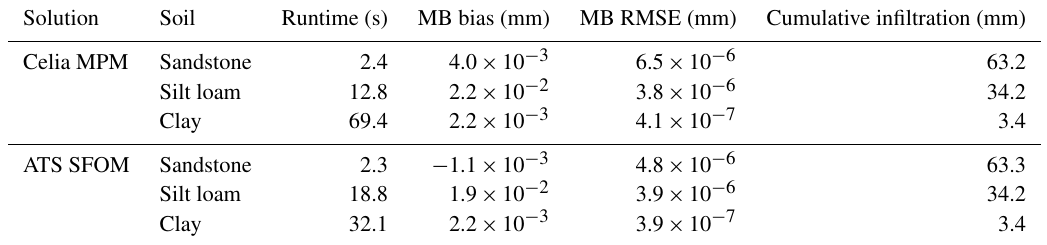
Table 4. Runtime and water balance performance for the Celia MPM and ATS SFOM solutions, applied to the problem described by Mathias and Sander (2021).